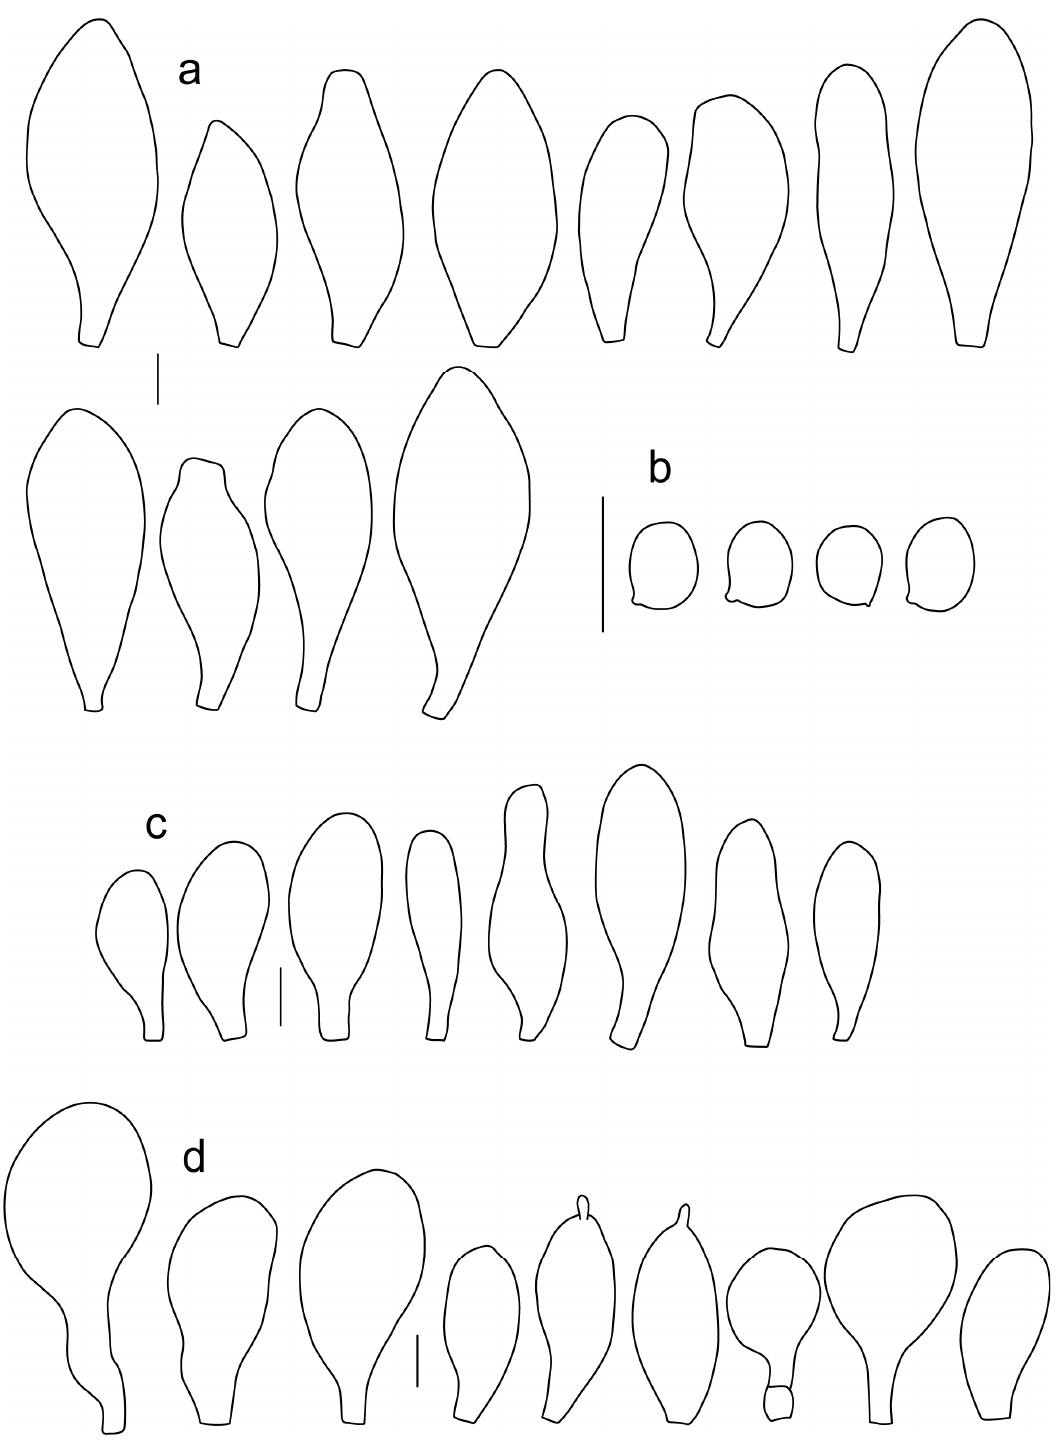
Figure 11. Pluteus austrofulvus ( a ). pleurocystidia, ( b ). basidiospores, ( c ). cheilocystidia, ( d ). pileipellis elements. Scale bars 10 µm.